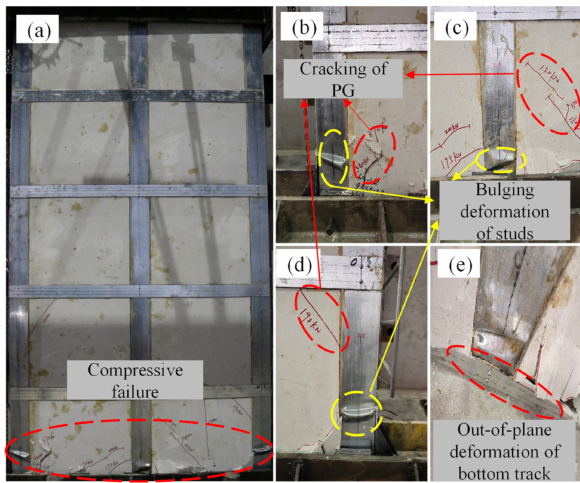
Figure 8. Failure of specimen